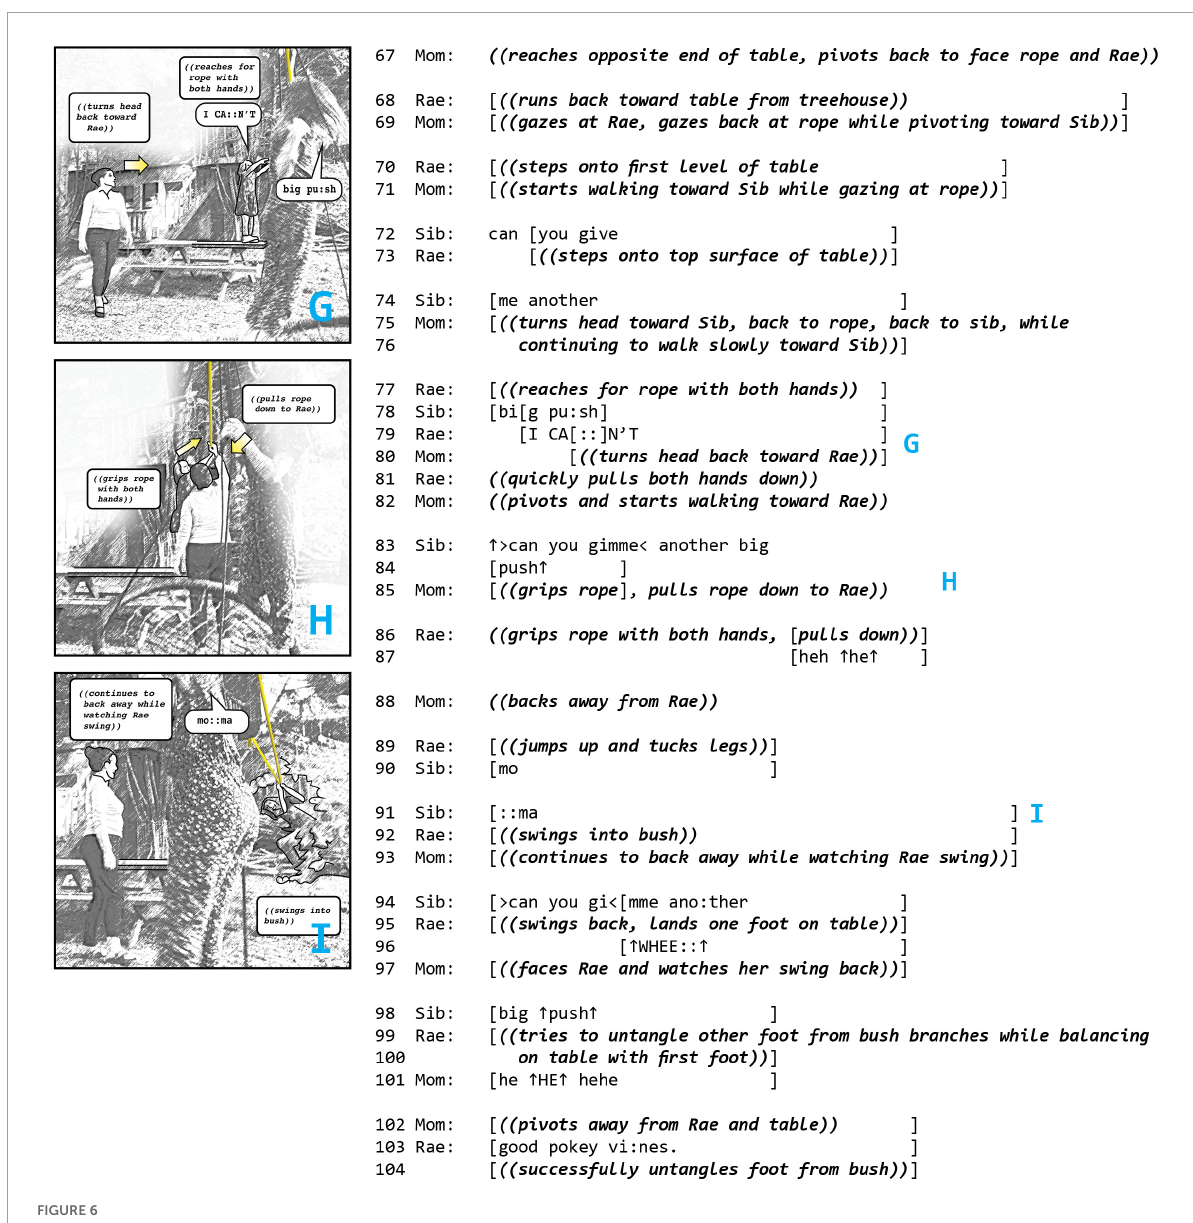
FIGURE6 Rae gets the rope with mom’s